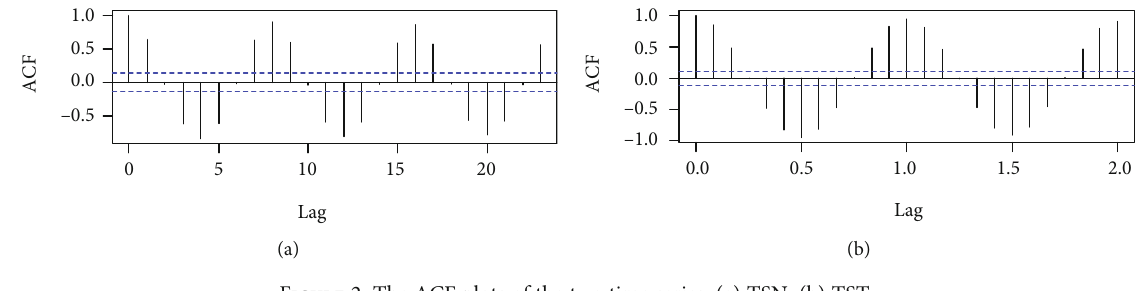
Figure 2: The ACF plots of the two time series: (a) TSN; (b) TST. Table 1: Optimal parameters of the BCT model and MSE estimates of the last curve of functional variable for the two time series datasets. Time series